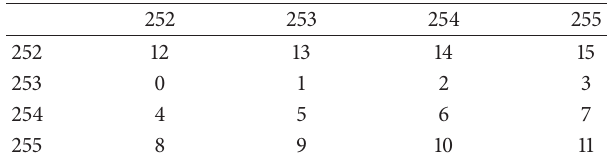
Table 2: The mapped